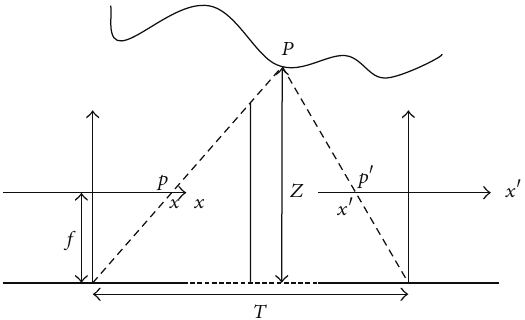
Figure 3: Relationship between depth and